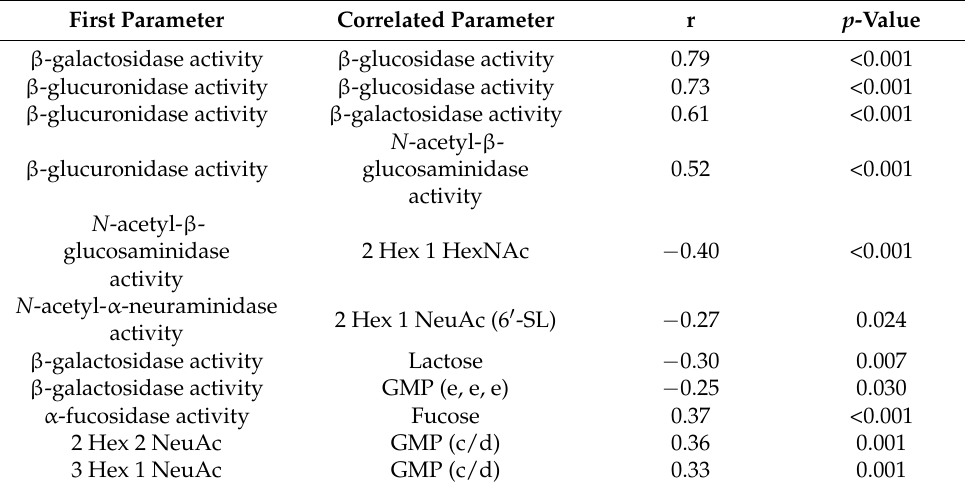
Table 1. Significant correlations among glycosidases, between glycosidases and glycans, as well as between different specific glycans. Included are Pearson correlation coefficients (r) and corresponding p -values. First